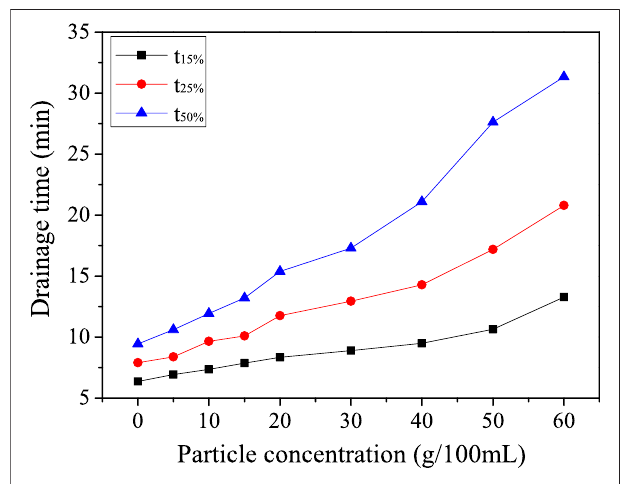
FIGURE 5 | Drainage time of foam with talc